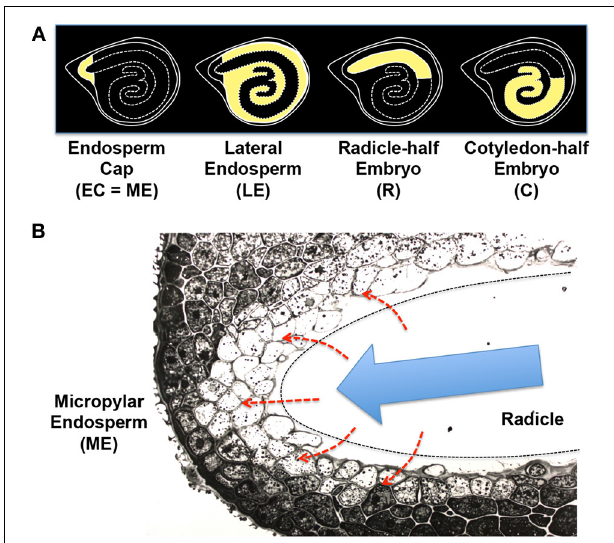
FIGURE 6 | Tomato seed tissues and regulatory mechanisms of endosperm weakening. (A) Schematic representation of the four different tissue parts of tomato seeds used for the transcriptome analysis (Martinez-Andujar et al., 2012). Endosperm cap [EC = ME (micropylar endosperm)], lateral endosperm (LE), radicle-half embryo (R), and cotyledon-half embryo (C) are highlighted by yellow filling. (B) Photograph of micropylar endosperm (ME) cells. The radicle tip (outlined by dashed line) has been removed. Note that cell walls are fuzzy and protein storage vacuoles and lipid bodies are disappearing in the inner layers of ME cells facing the embryo (Nonogaki et al., 1998). Possible secretion of GA or peptides from the embryo to the endosperm (red dashed arrows) and the growth potential generated by the embryo (blue arrow), which provides pressure onto the endosperm, are indicated in the scheme.